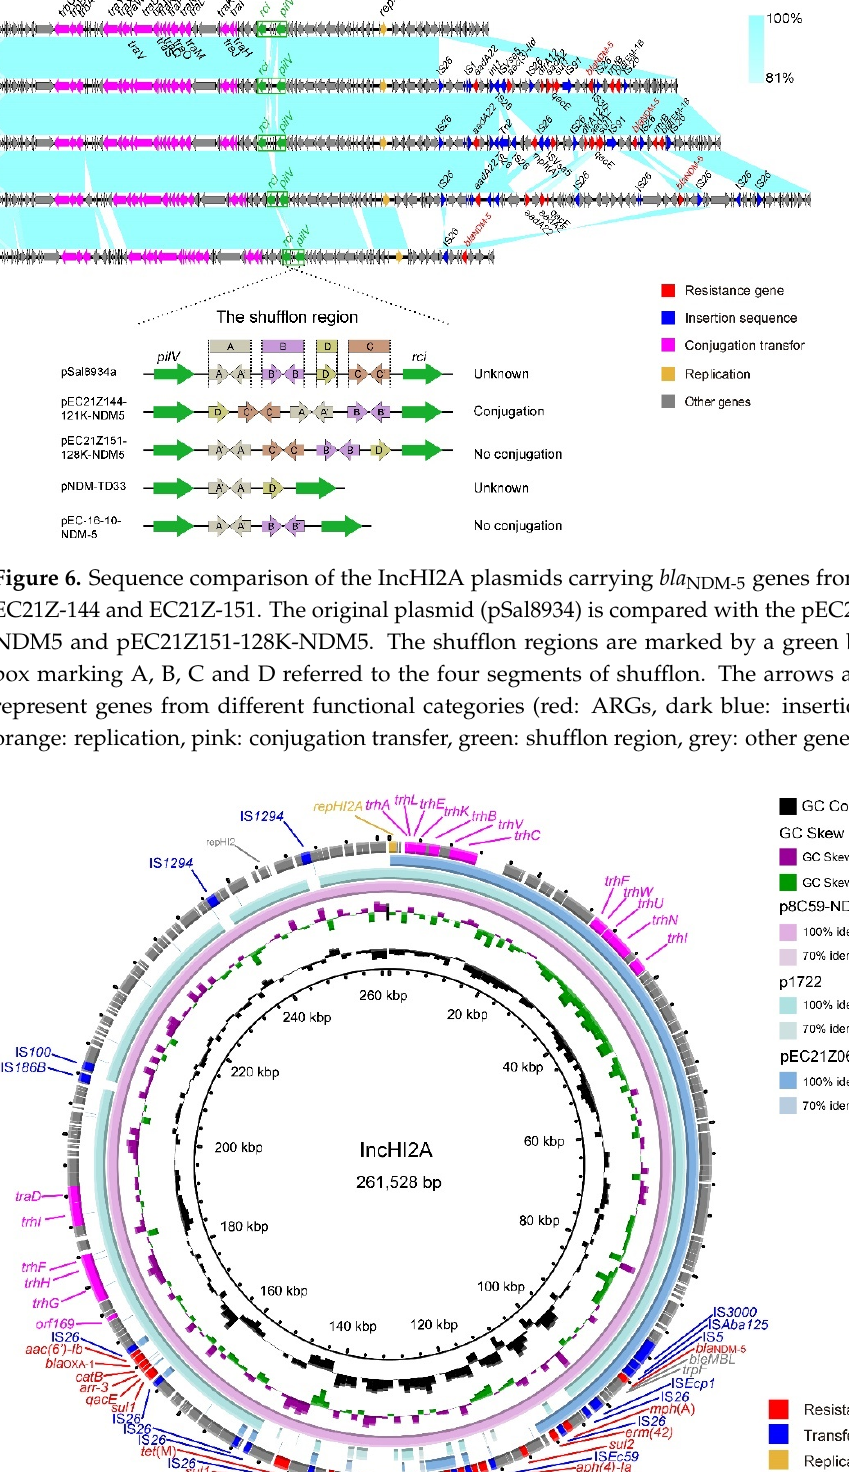
Figure 5. Sequence comparison of the IncX3 plasmids carrying bla NDM-1 and bla NDM-5 genes with the common plasmid backbone (pMTY18780-5_IncX3) in GenBank. Sequence similarity is shown in light blue. Arrows and triangles represent genes of different functional categories (red: resistance genes; dark blue: transfer elements; orange: replication; pink: conjugation transfer, grey: other genes).